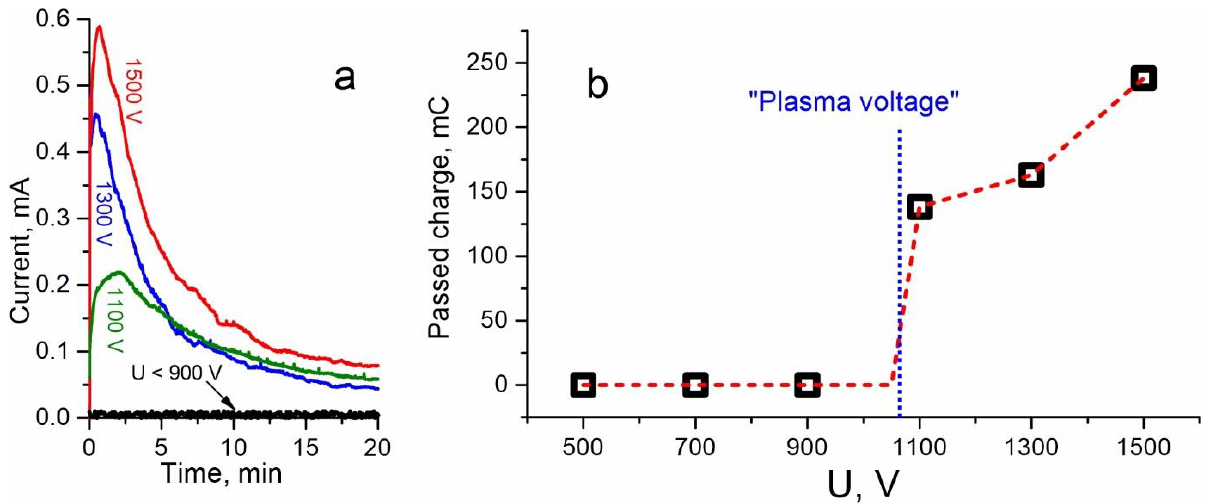
Figure 2. ( a ) Time dependencies of the current during the poling process of Menzel glass specimens subjected to different voltages. ( b ) Dependence of charge passed during 20-min-poling on the volt- age applied (dashed curve is a guide for an eye); the characteristic ignition voltage of plasma (“plasma voltage”) is indicated.